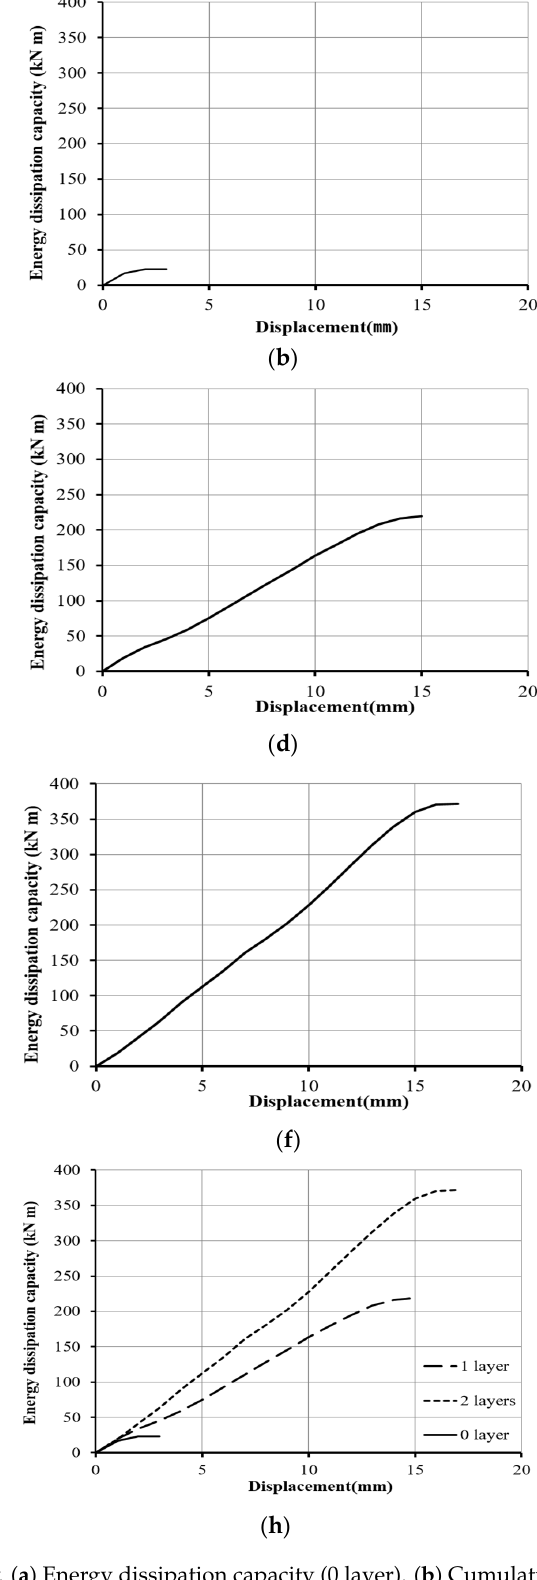
Figure 7. Displacement ductility and energy dissipation capacity. ( a ) Energy dissipation capacity (0 layer). ( b ) Cumulative energy dissipation capacity (0 layer). ( c ) Energy dissipation capacity (1 layer). ( d ) Cumulative energy dissipation capacity (1 layer). ( e ) Energy dissipation capacity (2 layer). ( f ) Cumulative energy dissipation capacity (2 layer). ( g ) Energy dissipation capacity (Total). ( h ) Cumulative energy dissipation capacity (Total).